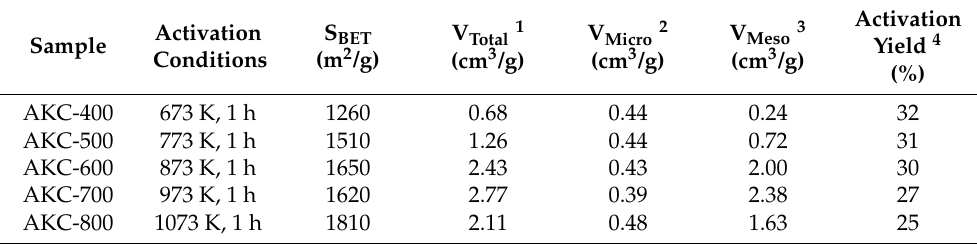
Table 1. Textural properties of kenaf-derived activated carbons as a function of various phosphoric acid activation temperature.